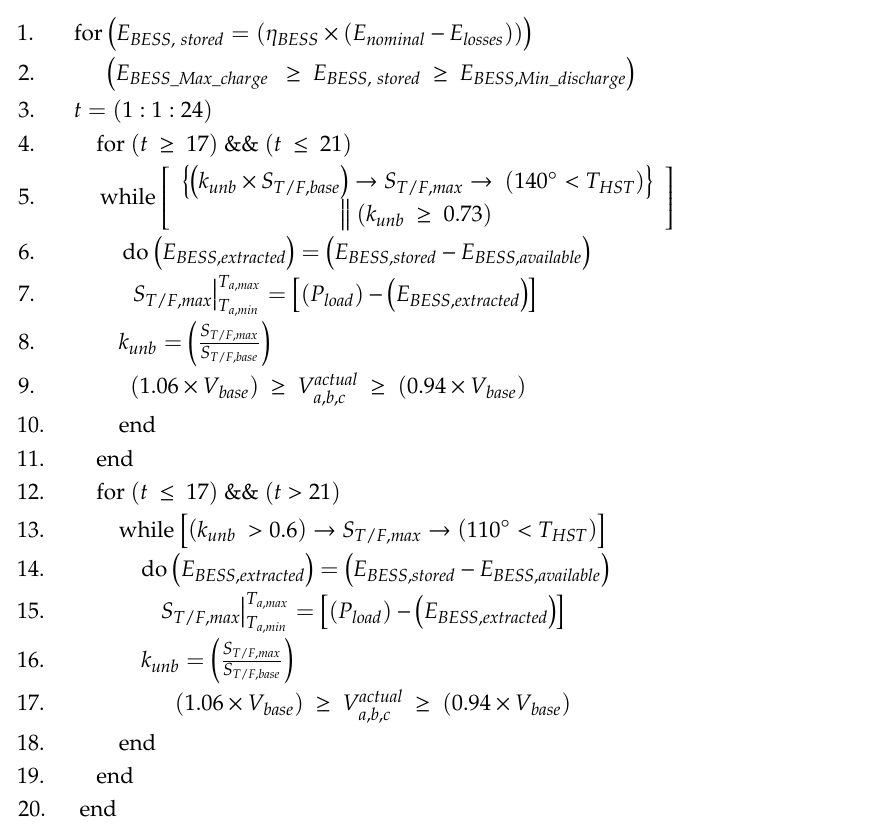
Algorithm 1. Proposed Technique during BESS